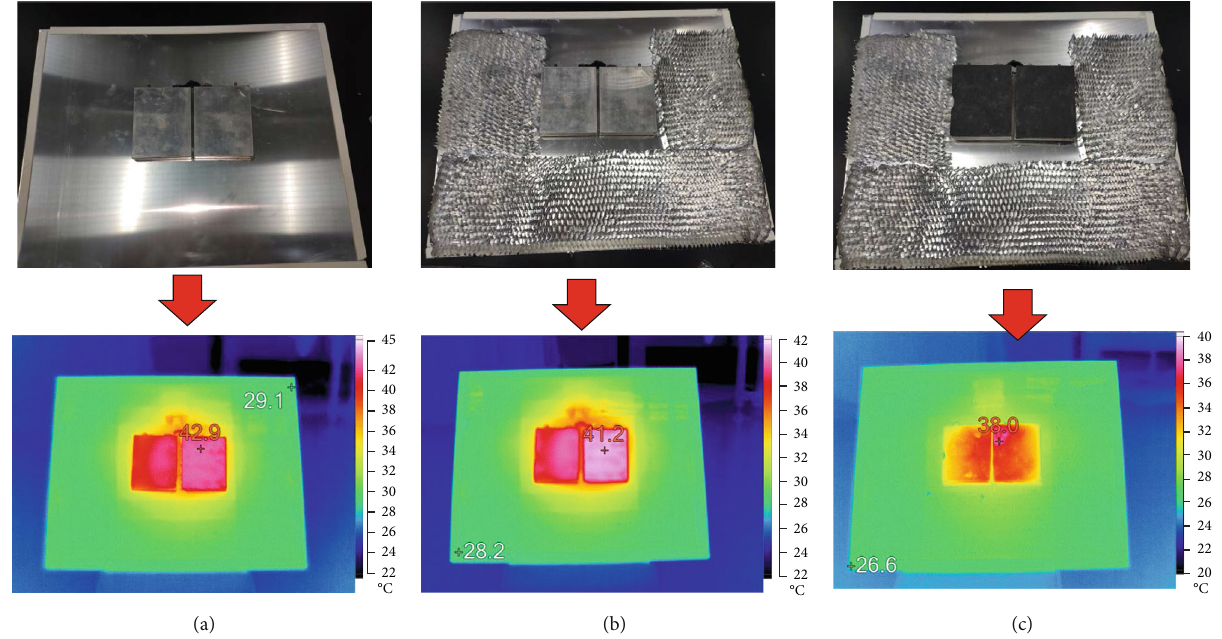
Figure 16: Infrared camera images after one hour of illumination: (a) PBIS – a, (b) PBIS – b, and (c) PBIS – c.